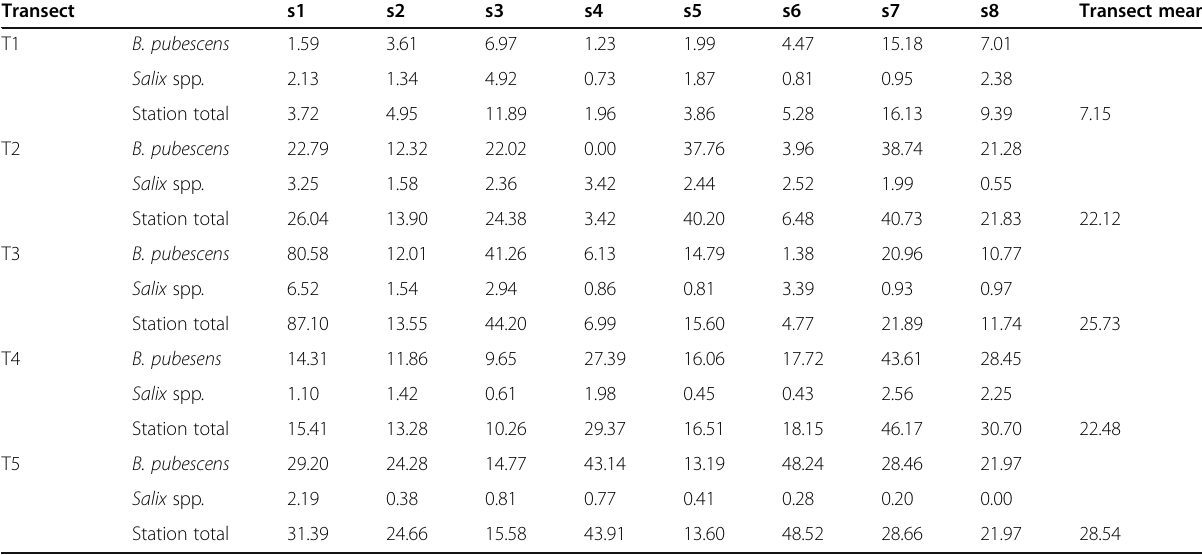
Table 6 Total biomass (AGB plus RB) by species for each station and transect, reported as g C m − 2 Transect s1